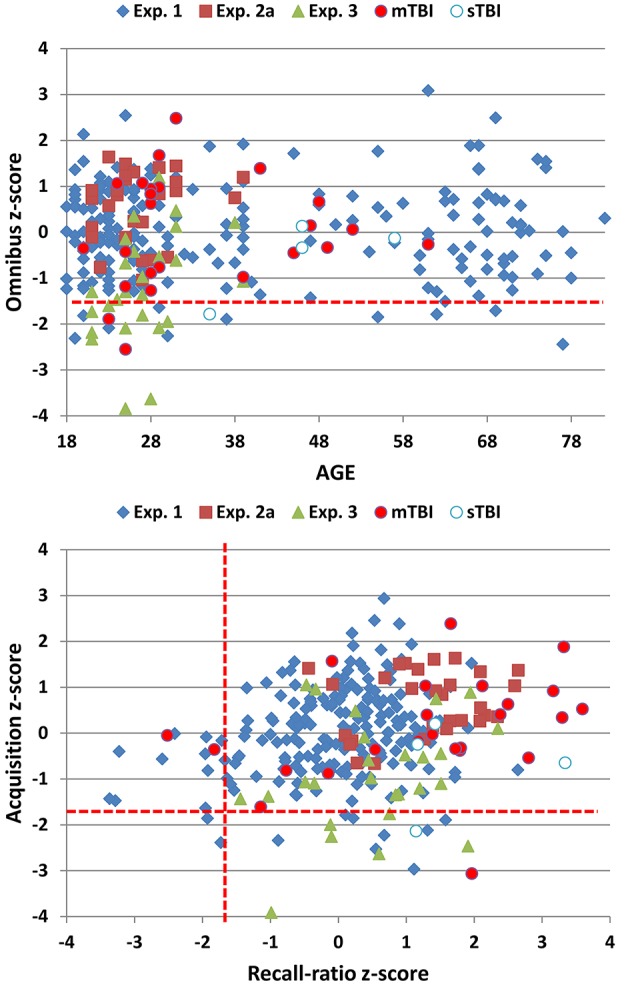
Top: Omnibus z-scores as a function of age. Bottom: Acquisition vs. recall-ratio z-scores. Omnibus and acquisition scores were transformed into z-scores after factoring out the contributions of age, sex, and education; recall-ratio z-scores factored out age and education. See Figure 2 for details. The dashed red lines show p < 0.05 abnormality thresholds for Experiment 1.